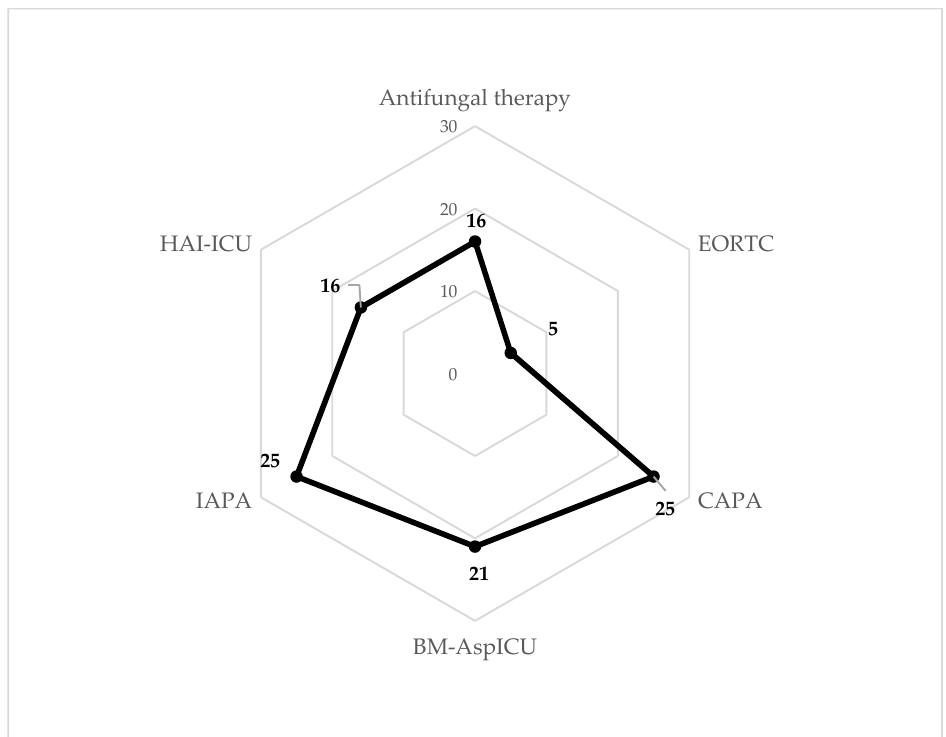
Figure 2. Network diagram of diagnostic criteria. Abbreviations: BM-AspICU = Biomarker-invasive aspergillosis in ICU; CAPA = COVID-19-associated pulmonary aspergillosis; EORTC/MSG = European Organization for the Research and Treatment of Cancer/Mycoses Study Group Education and Research Consortium; HAI-ICU = ECDC HAI-Net ICU protocol, vs. 2.2; IAPA = Influenza-associated pulmonary aspergillosis.